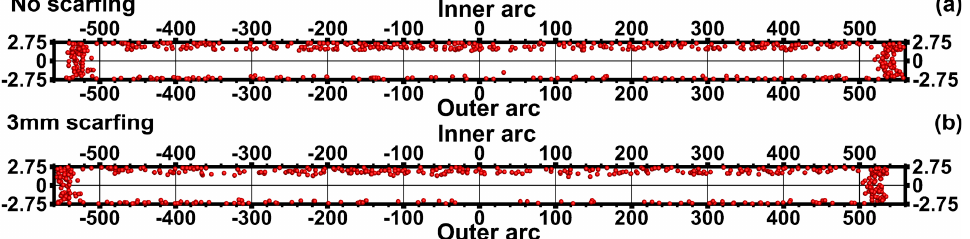
Figure 12. The distributions of inclusions in the hot-rolled plate after fi nishing rolling: the case without scar fi ng ( a ) and the case with 3 mm scar fi ng ( b ).